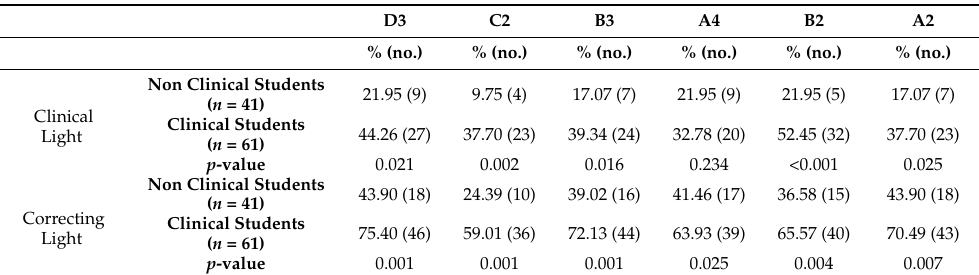
Table 3. Comparison of shade selection between non-clinical students and clinical students under clinical and correcting